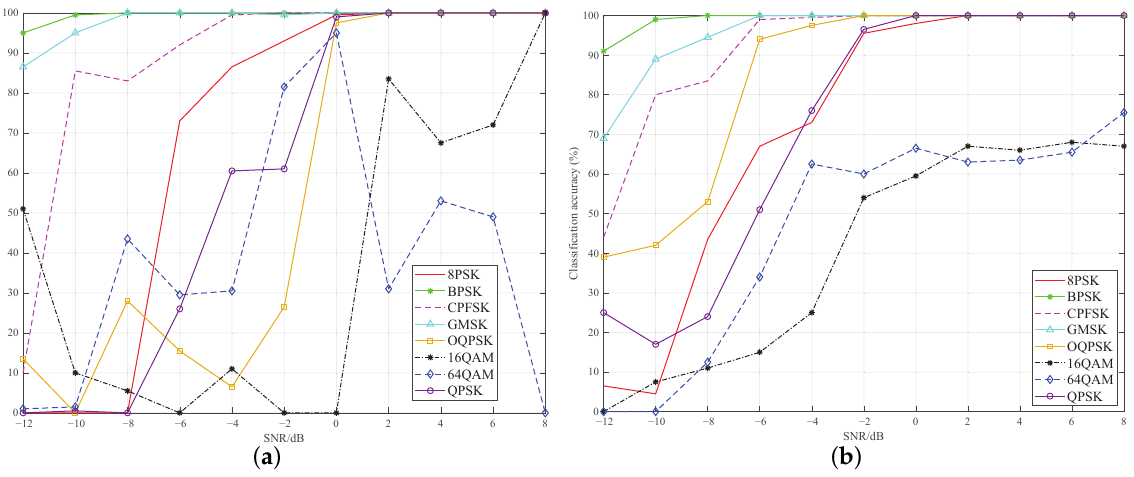
Figure 10. Classification accuracy of different networks for each modulation type. ( a ) DnCNN+CNN. ( b )